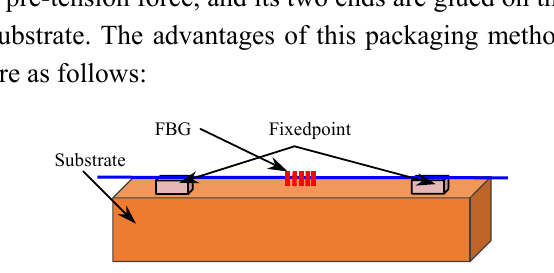
Fig. 13 Two-point packaging structure of the fiber optic